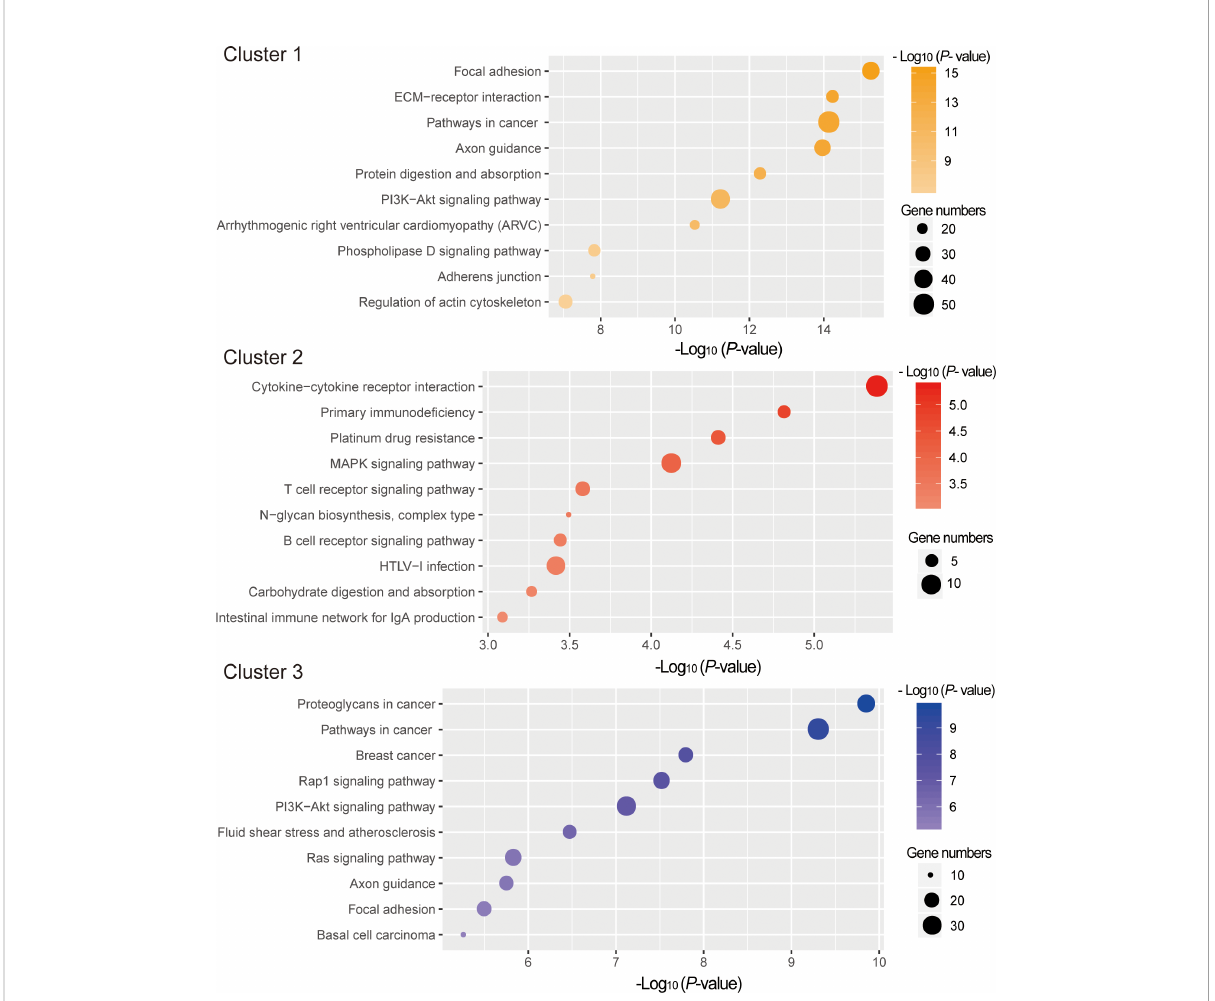
FIGURE 6 KEGG pathway analysis for DE mRNAs in different clusters. The x-axis indicates – log (P - value). The y-axis indicates KEGG